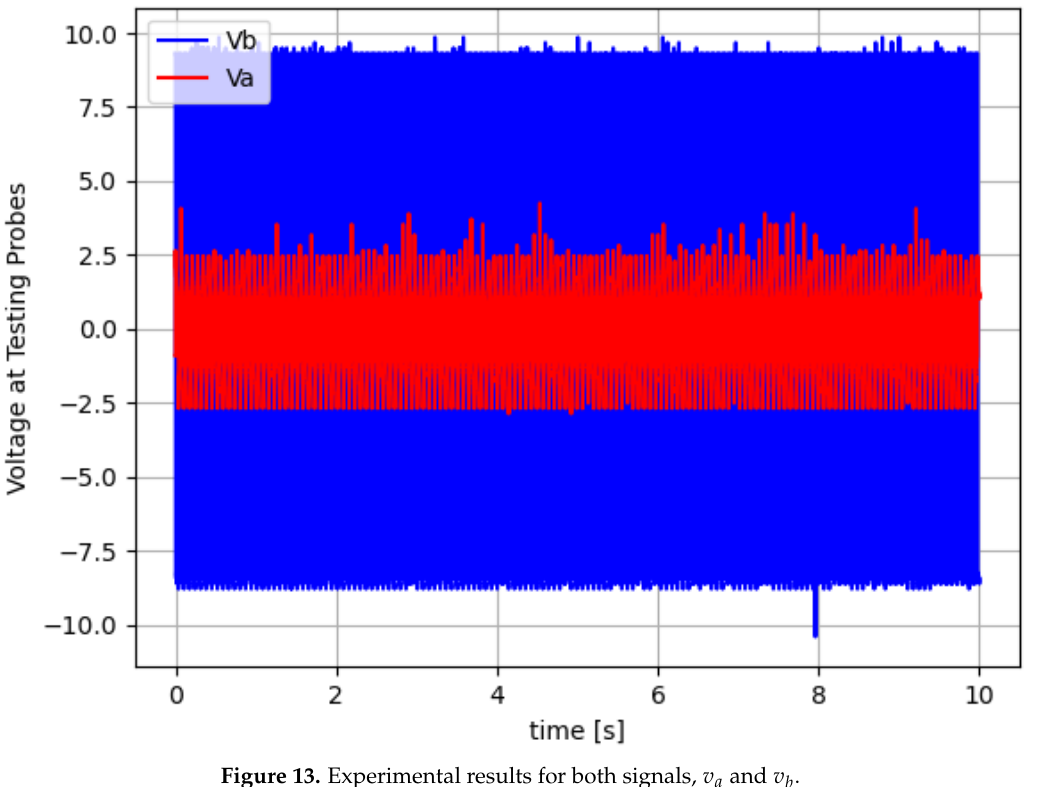
Figure 13. Experimental results for both signals, v a and v b .